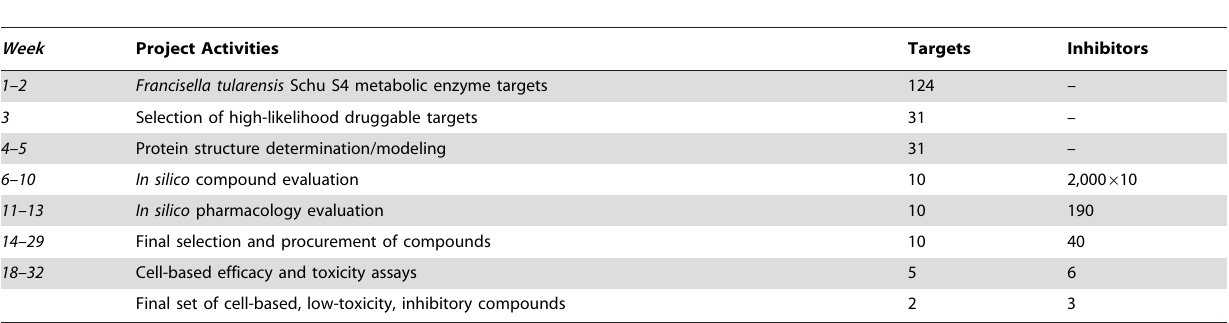
Table 4. Elements and results of the rapid countermeasure discovery